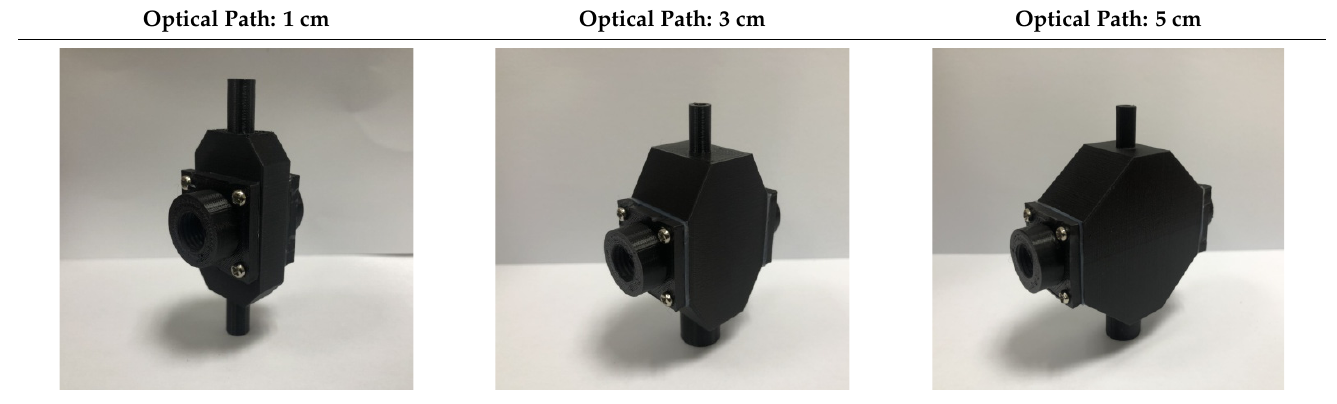
Table 1. Photos of molds with various optical paths.